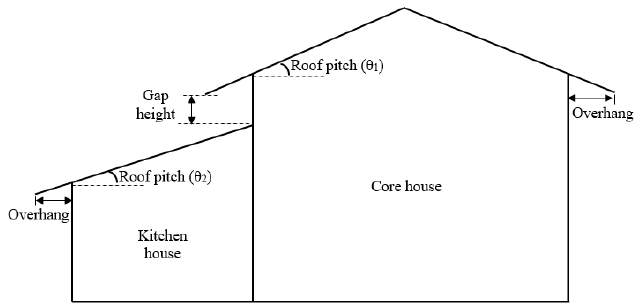
Figure 4. A typical cross section of a rural house.